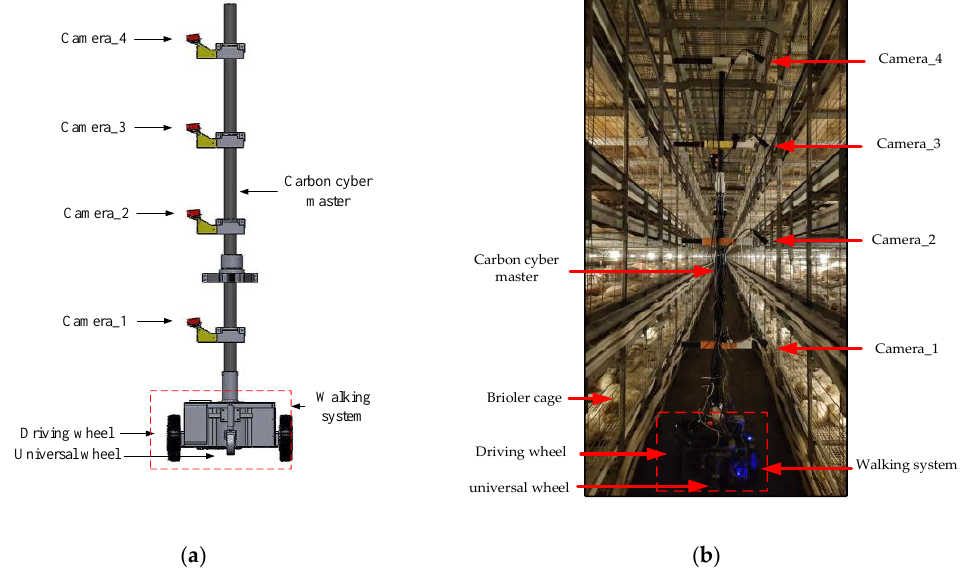
Figure 1. The autonomous inspection platform. ( a ) Schematic. ( b ) Experimental setup.